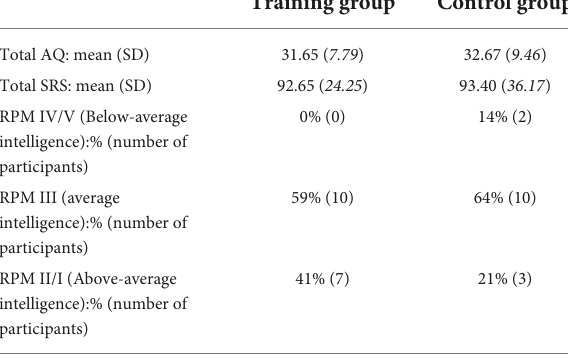
TABLE 3 Autism questionnaire (AQ), SRS, and RPM